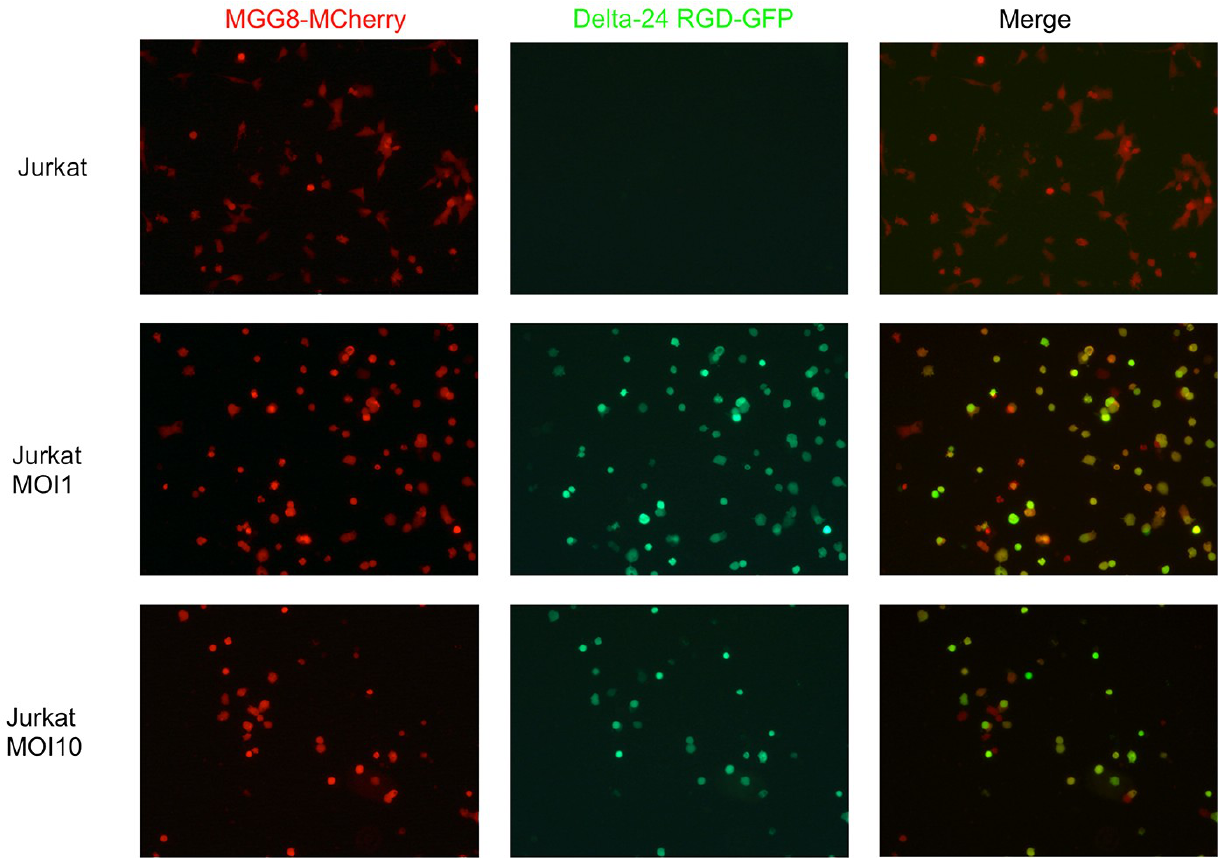
Figure 2. Jurkat T-cells efficiently deliver Delta24-RGD onto MGG8-GSCs in vitro . Cells were co-cultured for 96 h after prior incubation (24 h) of Jurkat T-cells with Delta24-RGD at the indicated dosages. ( Left ) mCherry fluorescence as assessed by conventional fluorescence microscopy with 25× optic zoom. ( Middle ) GFP fluorescence, indicating the presence of Delta24-RGD-GFP within cells. ( Right ) A merge of both mCherry and GFP results, demonstrating colocalization (yellow cells) indicative of Delta24-RGD-GFP transfer onto MGG8-mCherry